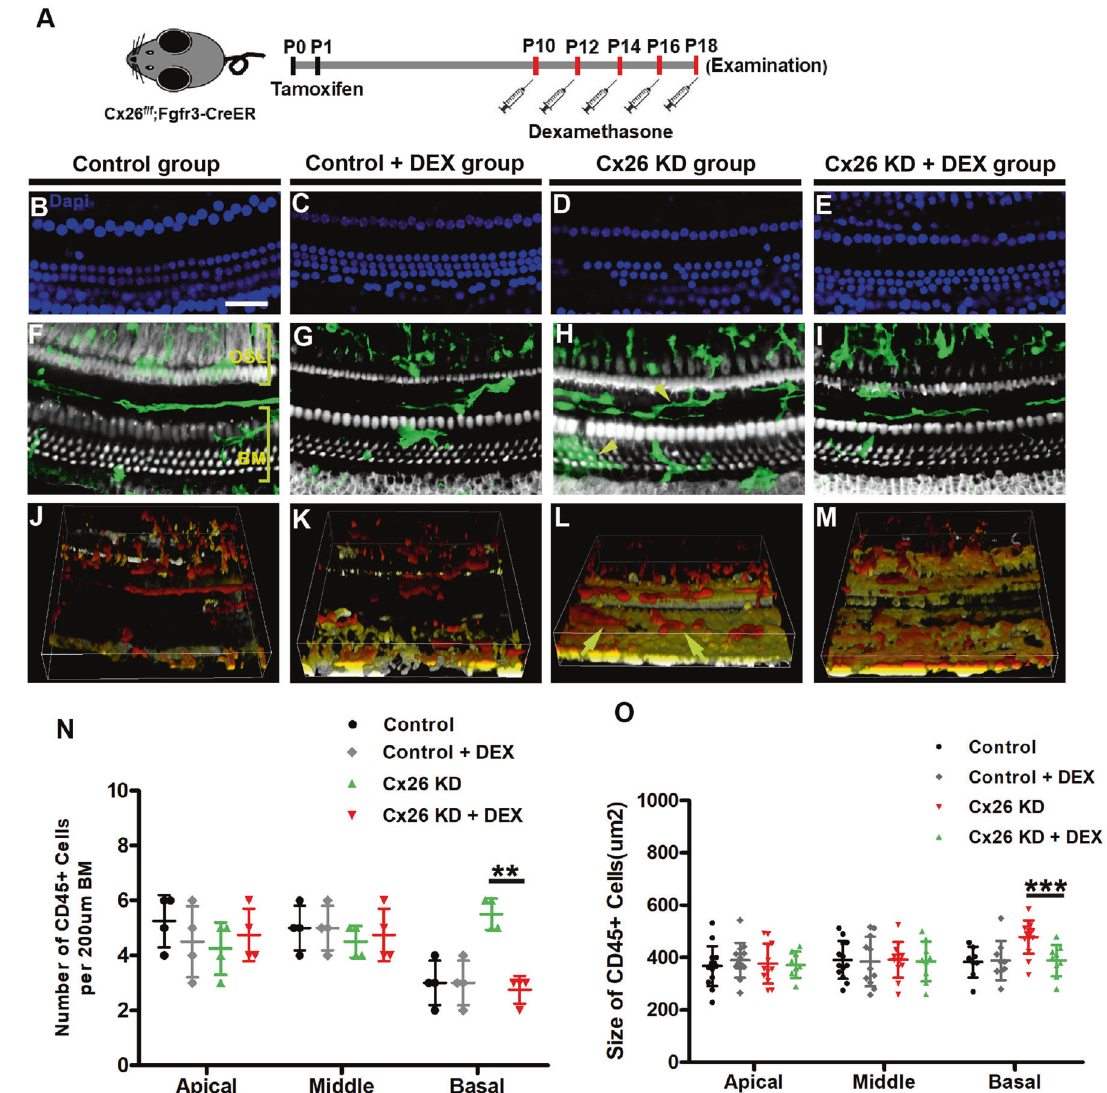
Fig. 6 Effects of dexamethasone on the number and morphology of macrophage in DC-targeted Cx26-null mice. A Schematic of the experimental work fl ow, Cx26 f/f ; Fgfr3-CreER mice were treated with TMX and then treated with dexamethasone 5 mg /kg of body weight for fi ve days. B – E Immuno fl uorescence staining with DAPI to show the pattern of hair cell damage from different group. F – I Immuno fl uorescence staining with CD45 (green) to visualized the distribution and morphology of macrophages in the basilar membrane from different groups. J – M The three-dimensional reconstruction of CD45 positive cells to show the morphology of CD45 positive cells from different groups. N Quanti fi cation of the numbers of CD45 positive cells on the scala tympani side of the basilar membrane in different groups. O Quanti fi cations of CD45 positive cells size in three turns from different group. n = 4 mice in each group, ** P < 0.01, *** P < 0.001. Scale in panels ( B , C ) represents for 40 μ